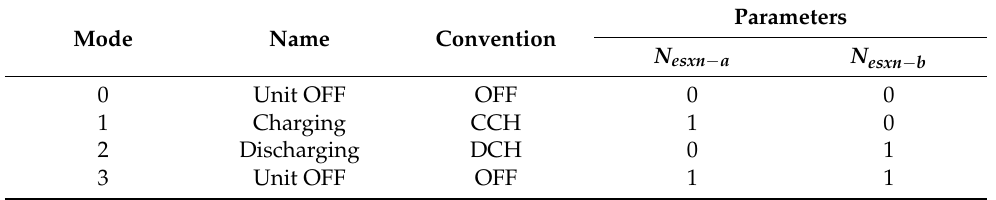
Table 3. Operation modes of the ESU.